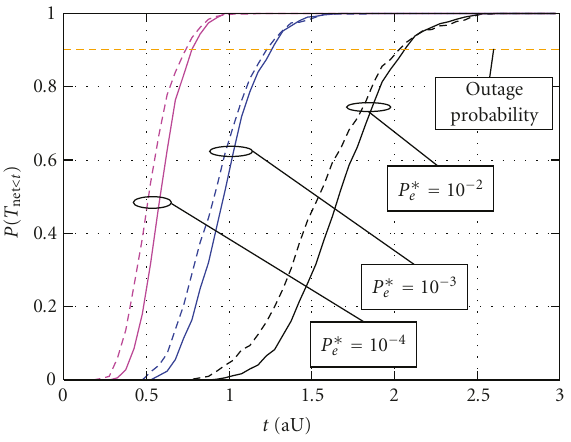
Figure 6: CDF of the network lifetime, as a function of time, in a scenario with N = 64 sensors, SNR sensor = 5dB, and absence of reclustering (simulation results). Three values for the maximum tol- are considered: (i) 10 − 2 , (ii) erable probability of decision error P ∗ e 10 − 3 , and (iii) 10 − 4 . Solid lines correspond to an initial topology with 2 clusters, whereas dashed lines are associated with an initial topology formed by 4 clusters. The distribution of the sensors’ life- time is